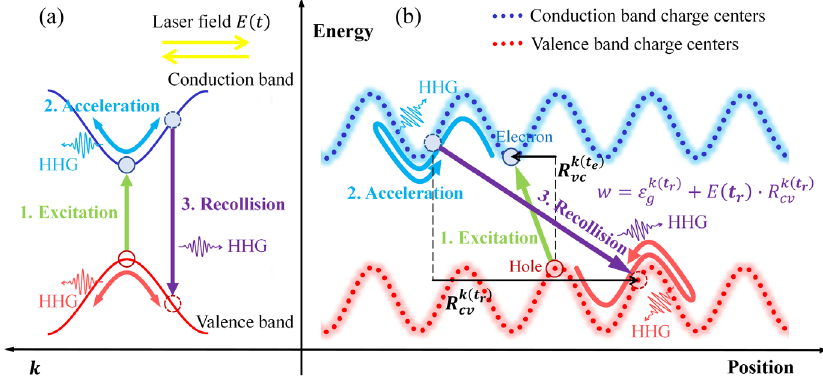
FIG. 1. Three-step model of solid HHG, including tunneling excitation (green), acceleration (blue and red), and recollision (purple). (a) Typical momentum-space diagram showing that the electron undergoes interband transition and intraband acceleration in strong laser fields. The momentum of the electron remains during the transition, and adiabatically evolves following the laser field during the acceleration, both of which produce high-frequency radiation. (b) Real-space representation for noncentrosymmetric systems under strong laser field E ð t Þ with contributions from the shift vector R k to HHG. The electron and hole pairs transferring among different cv charge centers are marked with blue and red dots in the wavelike dotted lines. In addition to variation in energy, the positions of the electron-hole pair in real space change with the oscillating laser field E ð t Þ . The displacements of the electron at the time of excitation and recollision can be described by the shift vectors, as the black arrows